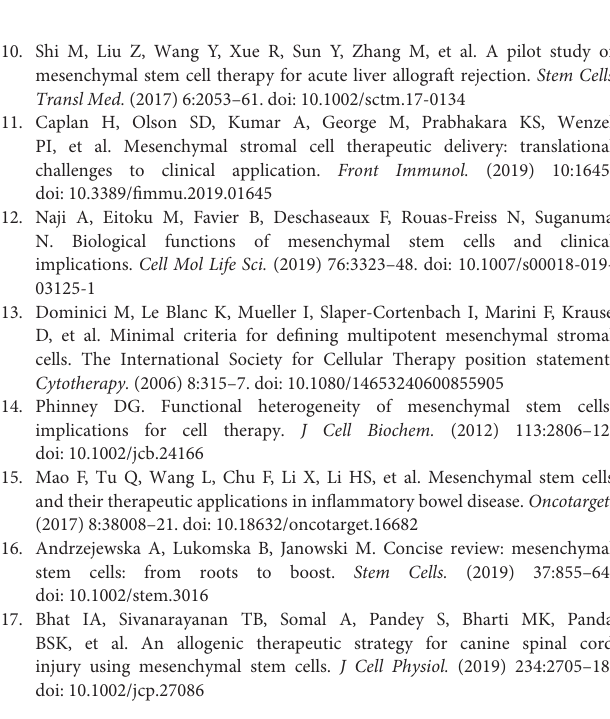
MSCs differentiation properties: Adipogenic differentiation. Stained with Oil Red; Osteogenic differentiation. Staining of alkaline phosphatase and von Kossa reaction; Chondrogenic differentiation. Staining with toluidine blue, safranin and alcian blue, respectively. Scale bar, 100 µ m. Supplementary Figure 2 | T2 proton relaxation dynamics in a magnetic field for MNPs water suspensions. Gray bars–MNPs in a magnetic field of 7.1T (iron concentration 0.02mM). Yellow bars–MNPs in a magnetic field of 0.33T, iron concentration 0.02mM. Blue bars–MNPs in a magnetic field of 7.1T, iron concentration 2mM. Data is presented as M SD. ± Supplementary Figure 3 | Macrophotos of the intact kidney wall (control) and pathological changes of the kidney 4 weeks following the intraparenchymal injection of Mtb , respectively. Black arrows indicate the focuses of TB infection. Hypersensitivity skin test on day 30 following Mtb inoculation. Supplementary Figure 4 | Real and imaginary parts of the non-linear magnetic response as functions of the dc magnetic field ( F sc 8Hz) of brain, heart, = pancreas, and stomach, exhibiting hysteretic (non-SPION-like) M 2 -signals, at different time points after injection of SPION-labeled MSCs. Supplementary Figure 5 | Real and imaginary parts of the non-linear magnetic response as functions of the dc magnetic field ( F sc 8Hz) of small intestine, = colon, femur, and bladder, exhibiting weak hysteretic (non-SPION-like) M 2 signals, at different time points after injection of SPION-labeled MSCs. Supplementary Figure 6 | Real and imaginary parts of the non-linear magnetic response as functions of the dc magnetic field ( F sc 8Hz) of kidney, lungs, liver, = spleen, paratracheal lymph nodes of healthy animals on days 3 and 7 following SPION-labeled MSCs injection. Supplementary Figure 7 | Real and imaginary parts of the non-linear magnetic response as functions of the dc magnetic field ( F sc 8Hz) of brain, heart, = pancreas, and stomach of healthy animals on days 3 and 7 following SPION-labeled MSCs injection. Supplementary Figure 8 | Real and imaginary parts of the non-linear magnetic response as functions of the dc magnetic field ( F sc 8Hz) of small intestine, = colon, femur, and bladder of healthy animals on days 3 and 7 following SPION-labeled MSCs